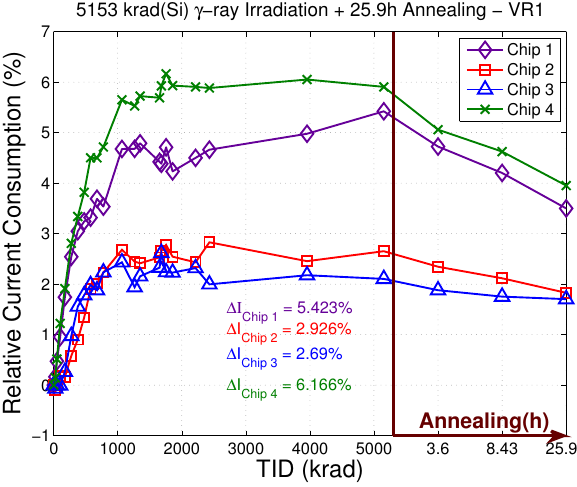
Figure 14. Relative current consumption (%) of the VR1 when exposed to γ -rays at a dose rate of 25 krad/h(Si).